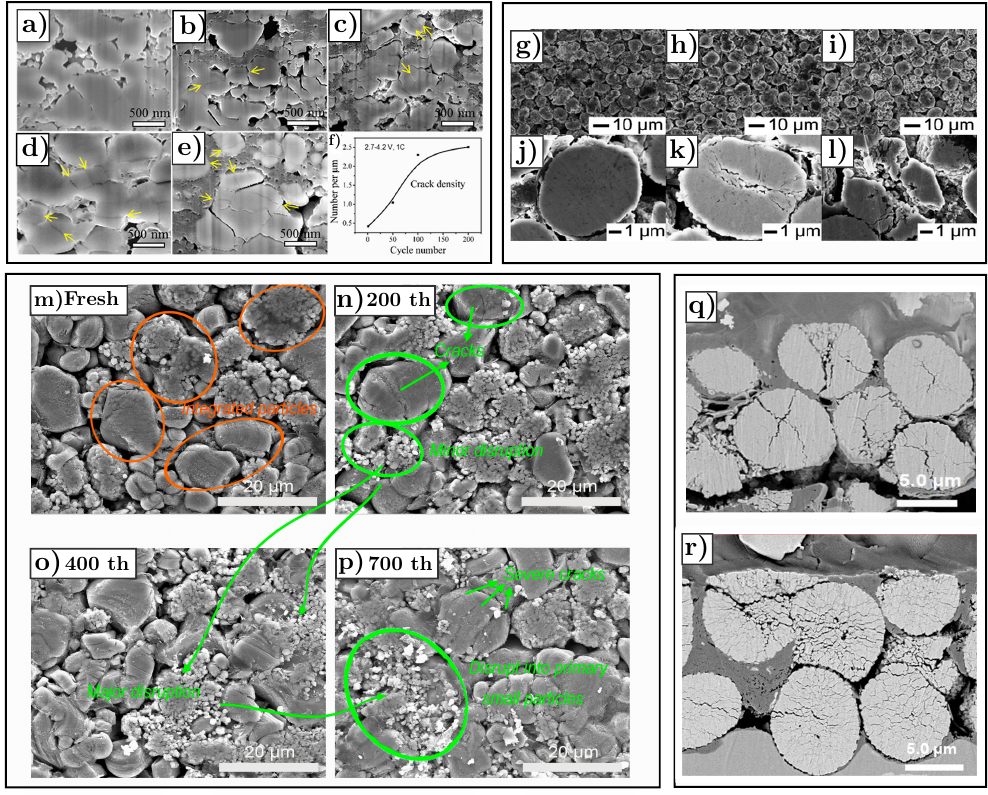
Figure 33. ( a – f ) Cross sectional SEM images of cracks evolution in LiFePO 4 cathode cycled at 1C. Samples ( a ) before cycling, ( b ) after 1 cycle, ( c ) after 50 cycles, ( d ) after 100 cycles, ( e ) after 200 cycles, and ( f ) crack density as a function of the cycle numbers. Reprinted with permission by American Chemical Society from [99], Copyright 2018. Top view and cross-sectional SEM images of the NCM851005 cathode ( g , j ) before cycling, ( h , k ) after 100 cycles and ( i , l ) after 500 cycles at 1C. Reprinted with permission by American Chemical Society from [154], Copyright 2019. ( m – p ) FESEM images of hervester LCO/NMC532 cathode electrodes at various cycle numbers. Reprinted with permission by MDPI from [153], Copyright 2017. ( q , r ) Cross-sectional SEM images ofLi[Ni 0.90 Co 0.05 Mn 0.05 ]O 2 at first cycle and after 1000 cycles, respectively. Reprinted with permission by American Chemical Society from [152], Copyright